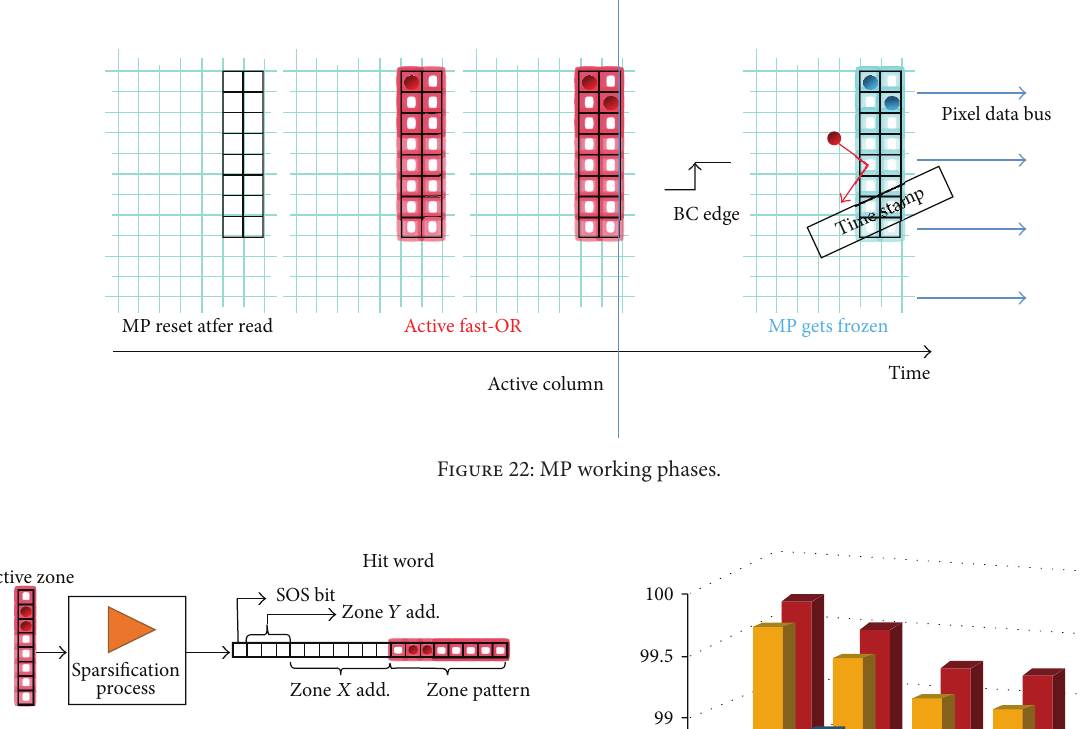
Figure 23: Zone sparsification diagram.